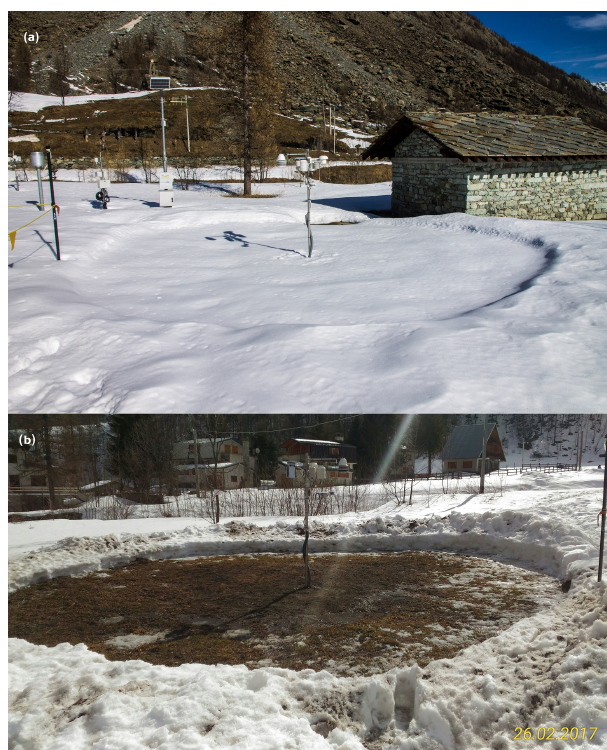
Figure 5. (a) The measurement site in its snow-covered state. Shown in the background is position a , where snow will be left. In the foreground, position b is shown, with the snow still to be removed. (b) Point b in a snow-free